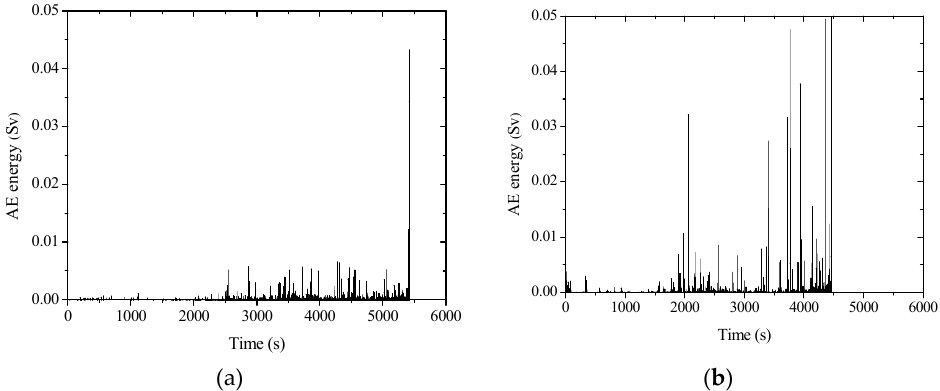
Figure 11. AE energy graph: ( a ) non-corroded column, and ( b ) corroded column.